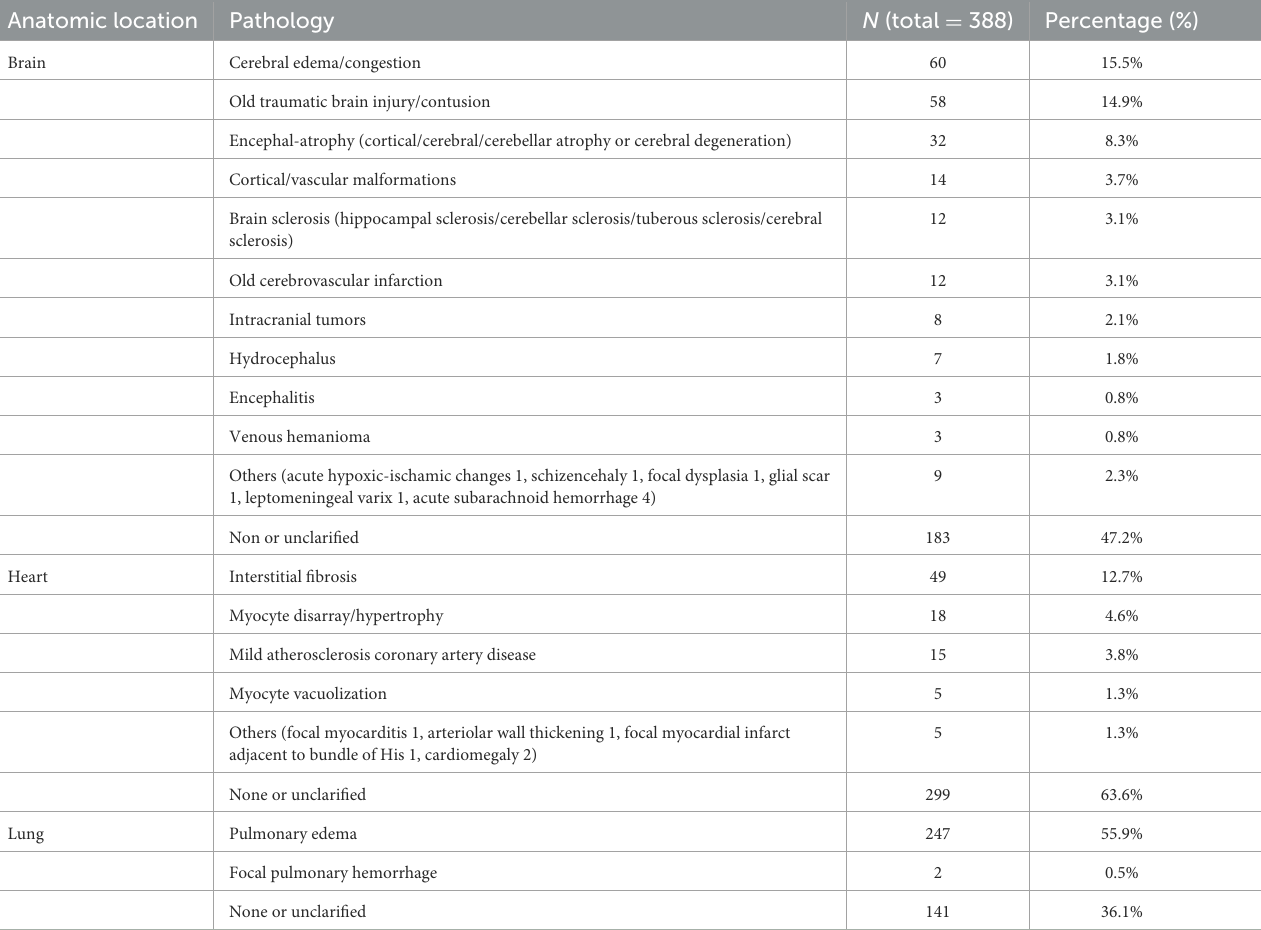
TABLE 3 Major autopsy findings at the brain, the heart, and the lungs for sudden unexpected death in epilepsy (SUDEP) cases. Anatomic